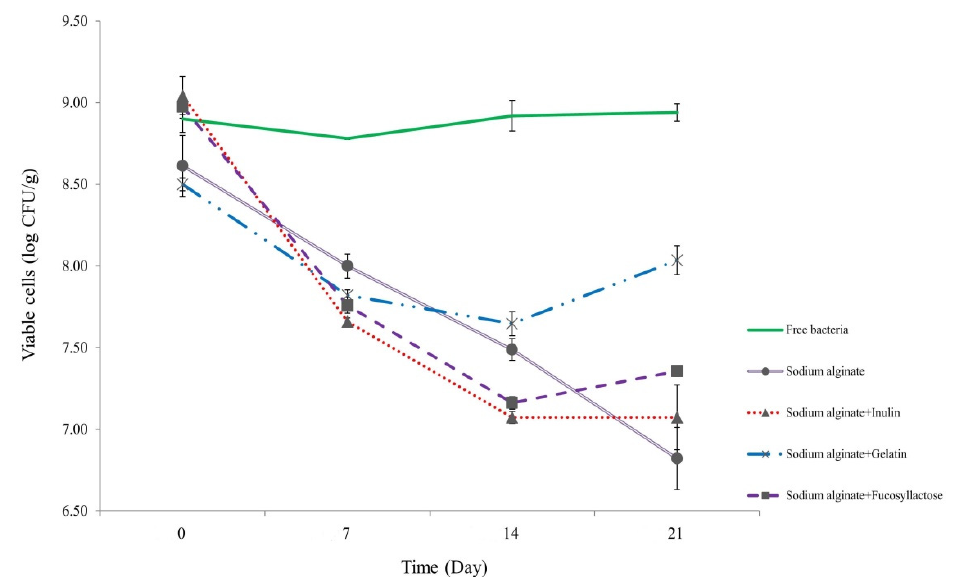
Figure 2. Survivability of encapsulated and free S. thermophilus TH982 cells during 21 days of storage in skimmed milk at 4 °C.